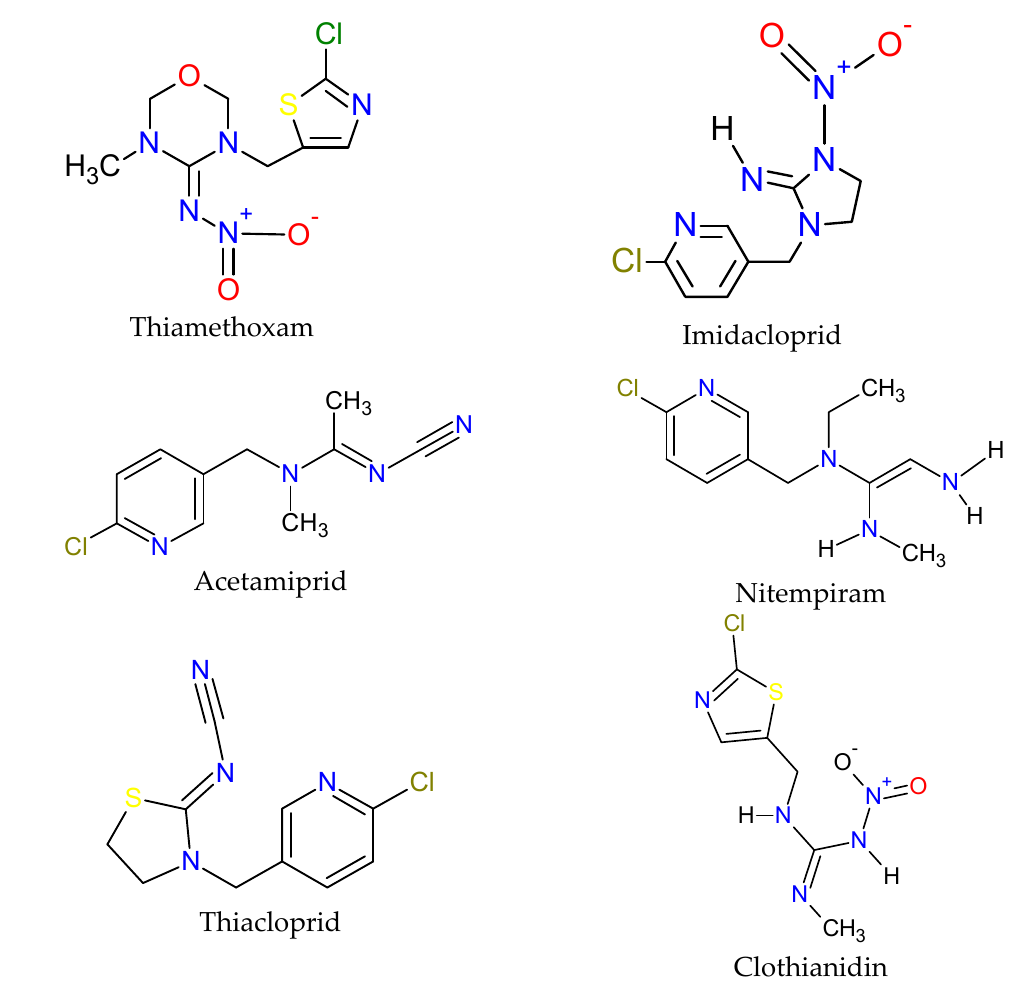
Figure 4. Structural formula of the main pyrethroids.